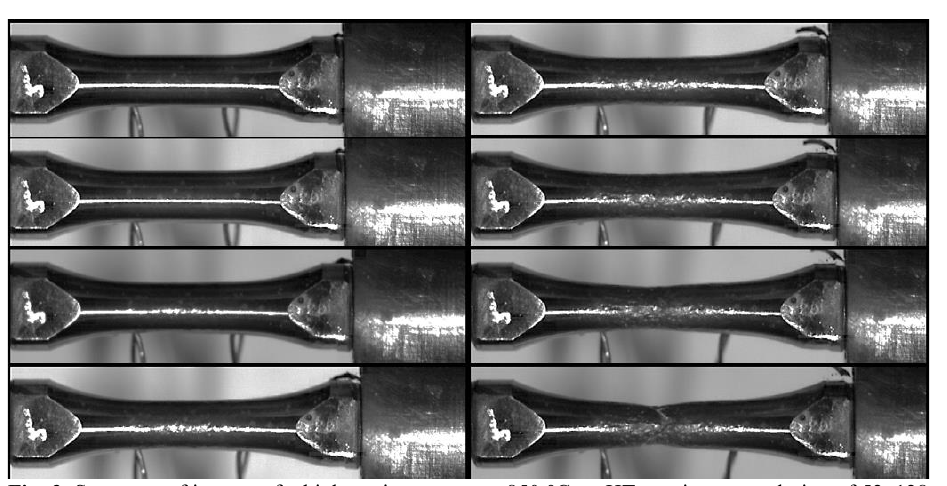
Fig. 3. Sequence of images of a high strain rate test at 850 °C on HT specimen: resolution of 52x128 pixels, framerate of 100000 fps, shutter of 1/1000000 s, time interval between the reported images of 50